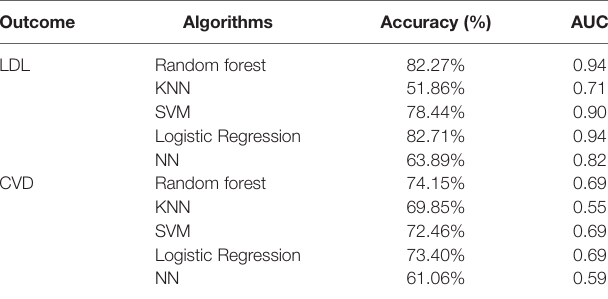
TABLE 3 | Comparison of validation result of LDL and CVD